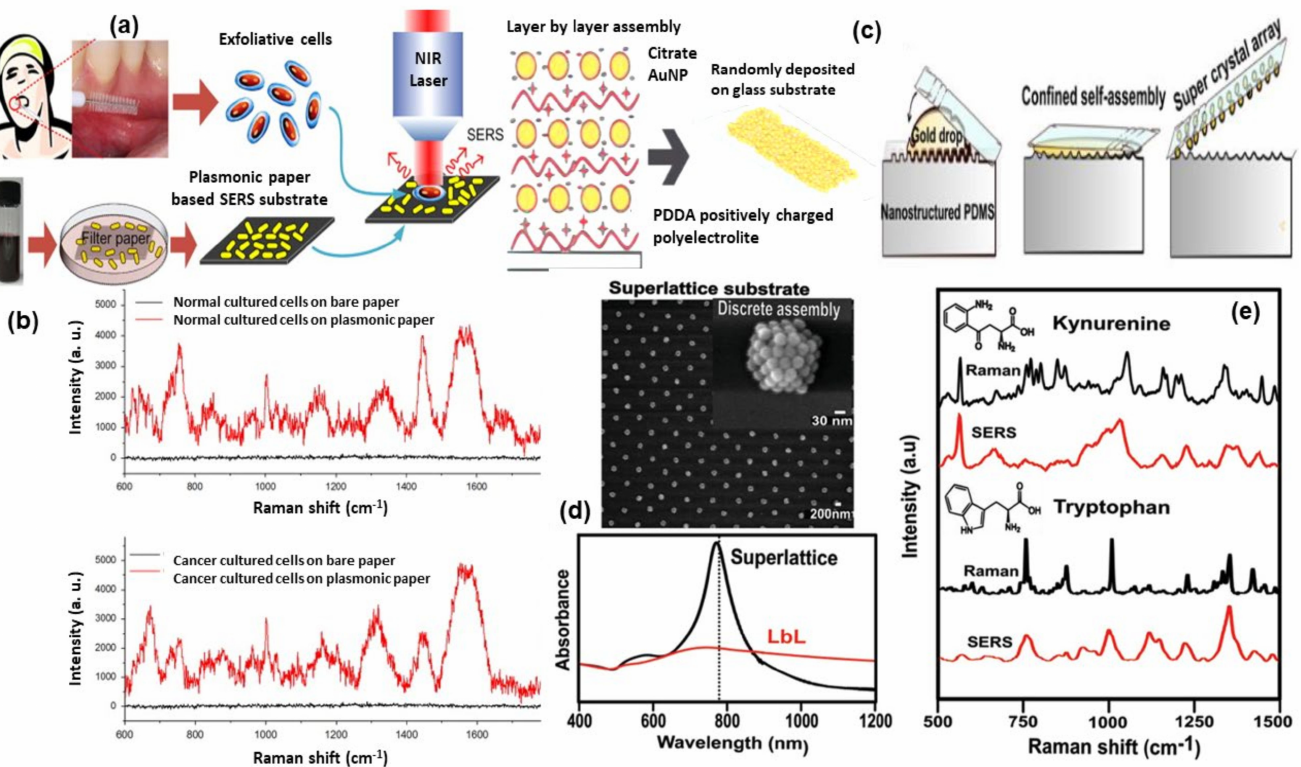
Figure 7. Panel ( a ) shows the illustration of paper-based SERS substrate and SERS examination of the exfoliated cells obtained from oral-cancer patients. Panel ( b ) represents the SERS spectra from the exfoliated cells: normal tissue (top) and cancerous tissue (down) [116]. Panel ( c ) shows the methodology of super-lattice SERS substrate fabrication and its SEM image and Vis-NIR spectra are shown in panel ( d ). Panel ( e ) shows the comparison of Raman and SERS spectra for kynurenine (Kyn) and tryptophan (Trp). Reproduced with permission from Wiley publications of ref.